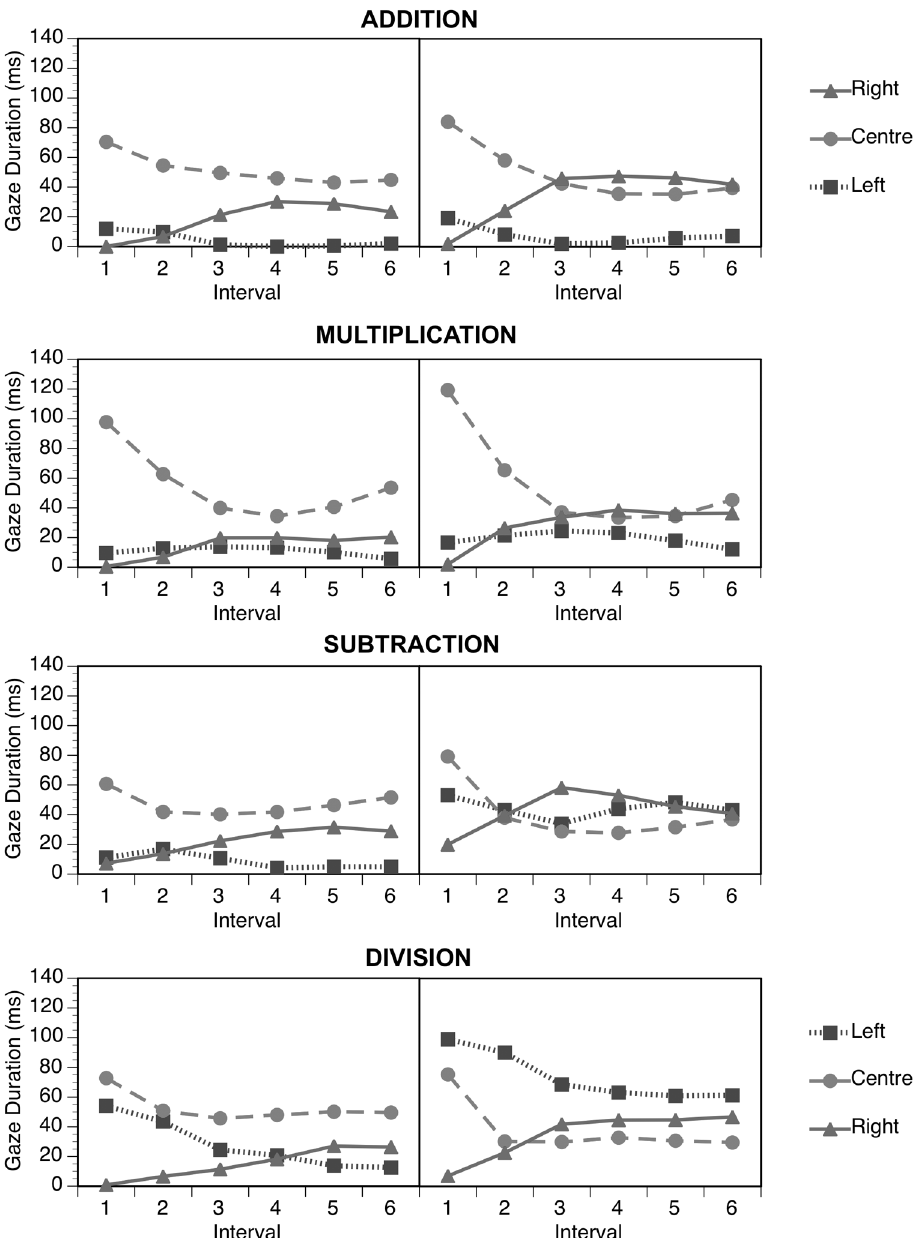
Figure 4. Means of median values of time-normalized gaze durations by operation and problem size for each interest area (see text for